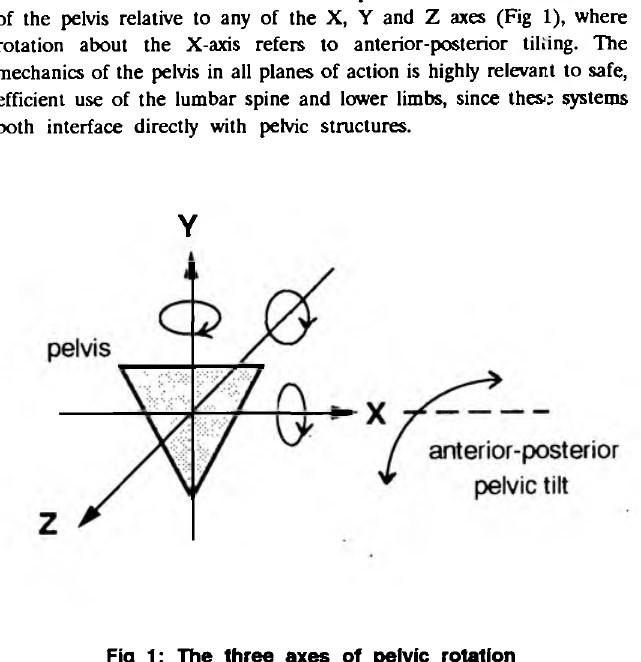
Fig 1: The three axes of pelvic